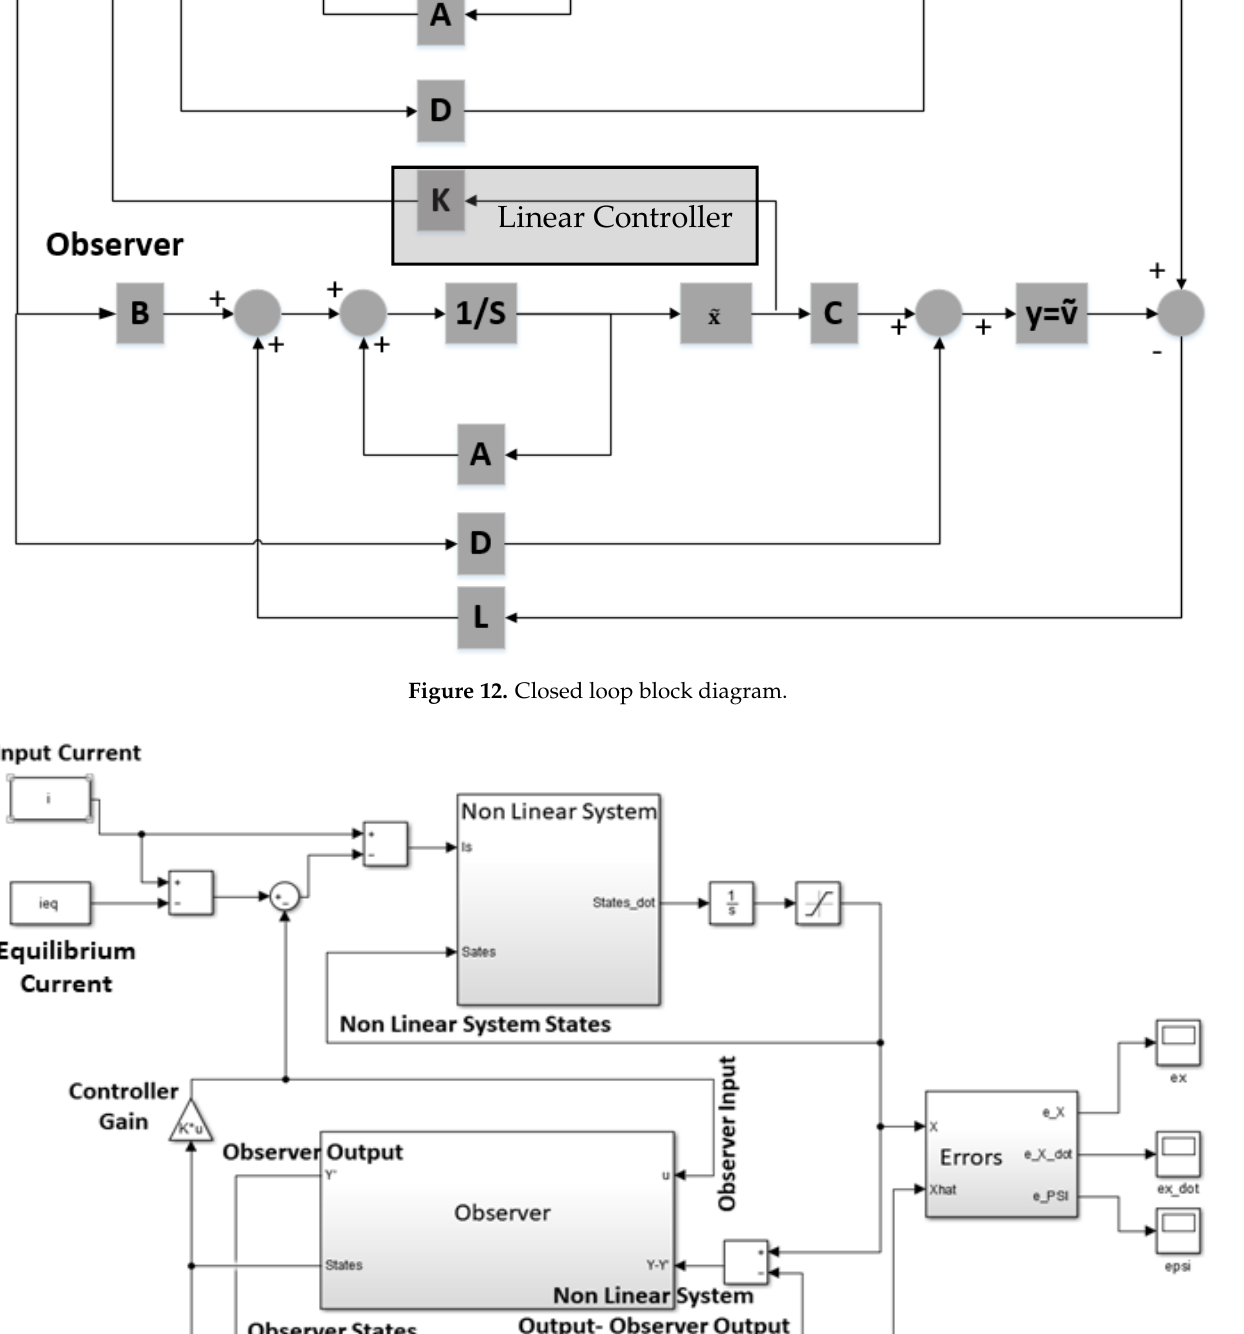
Figure 13. Simulink implementation of the nonlinear system, controller and observer. Figures 14–16 depicts the system output, with the observer and the linear controller, for the following initial conditions: •